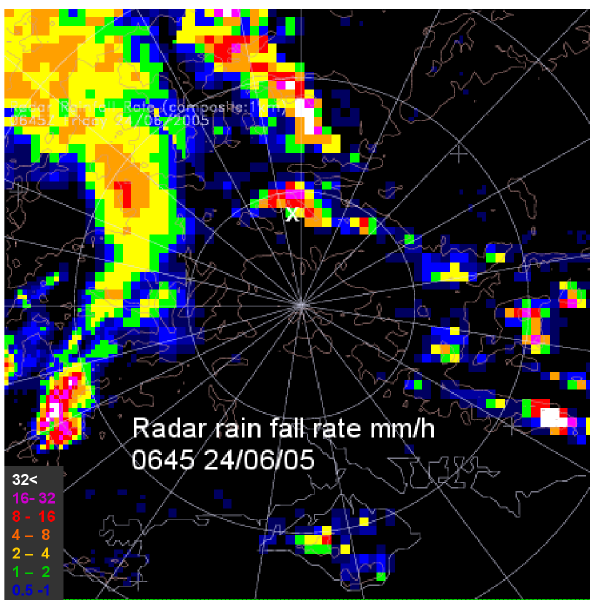
Fig. 3a. Composite weather radar rainfall for the 24 June 2005 at 06:15UTC. The white cross indicate Linkenholt site. The rain rate/h is indicated by the colour scale on the bottom left. The bulls- eye is centred at the Chilbolton radar with the first and second cir- cles of radius 25 and 50km.